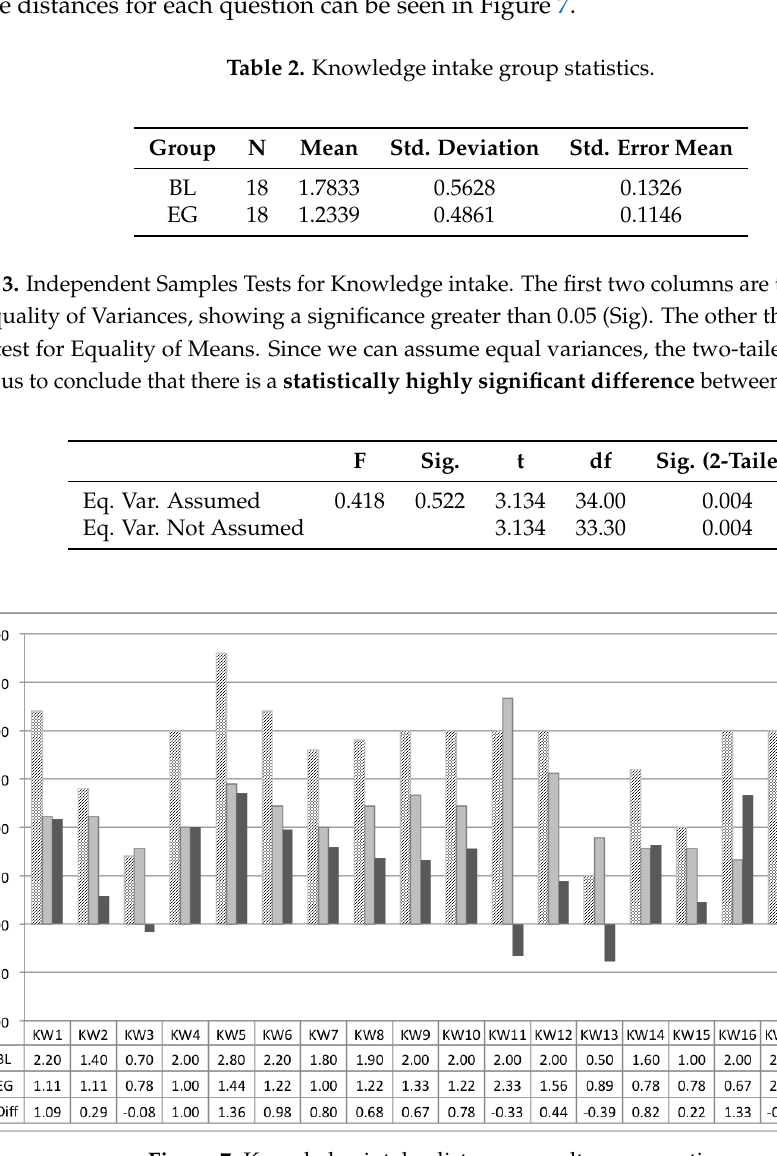
Figure 7. Knowledge intake distances results, per